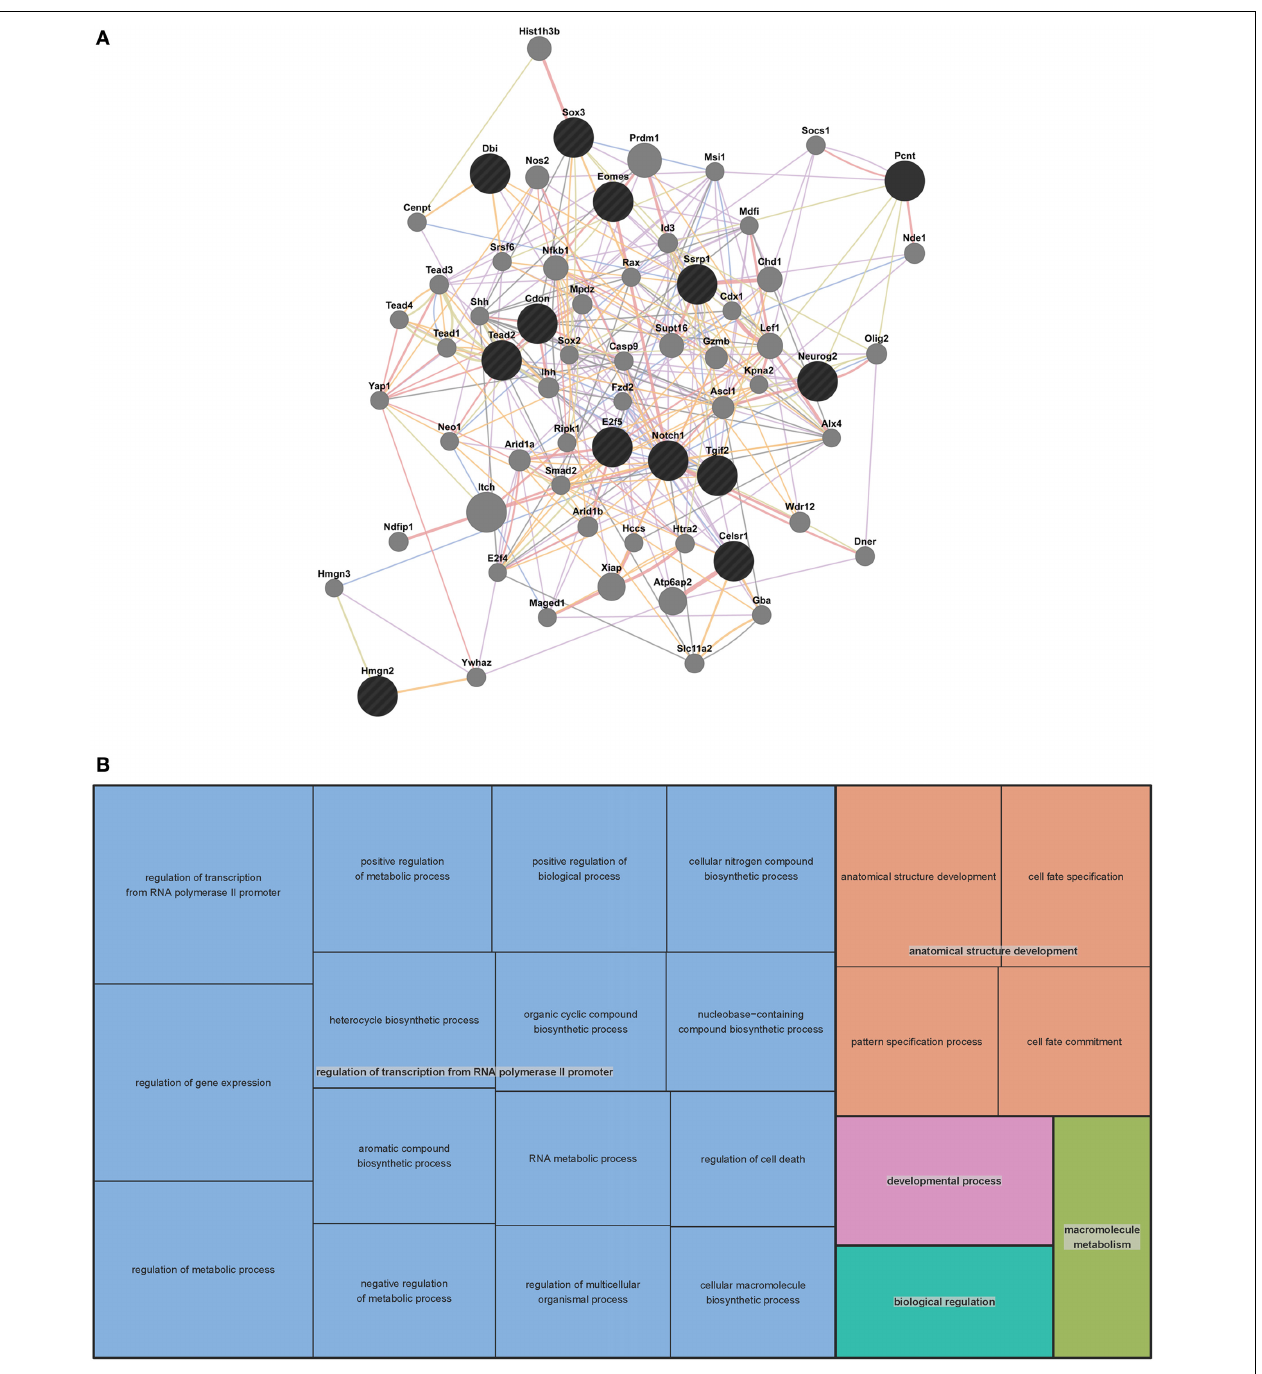
FIGURE 2 | Mouse extended association analysis network and Gene Ontology (GO) analysis of network genes. (A) Association analysis of the 13 mouse VZ network genes. 50 associated genes are shown in the extended network. Black circles indicate the genes that were searched through GeneMANIAandthegraycirclesareassociatedgenes.Theedgesareindicated byassociationsfoundthroughco-expression(purplelines),co-localization(blue lines), physical interaction (pink lines), predicted (orange lines) and shared protein domains (tan lines). Table S1 contains complete network details and